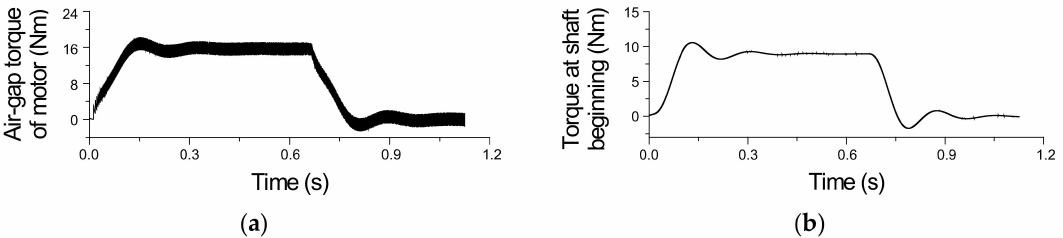
Figure 15. Waveforms of the air-gap torque ( a ) and the torque at the beginning of the shaft ( b ) during motor start-up in the system shown in Figure 7 for the 0.056 kg · m 2 moment of inertia of the total mass containing the rotor of the DC generator and the disc installed at the end of the